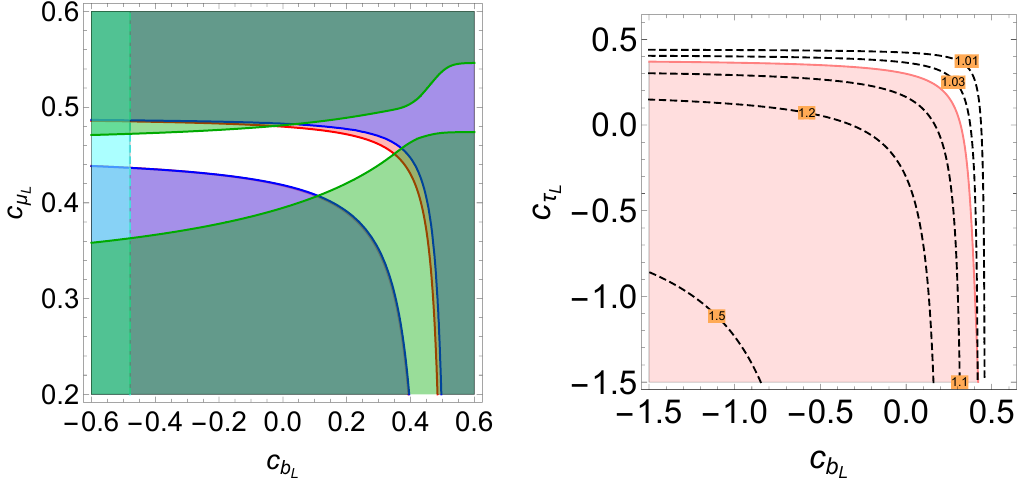
Figure 20 . Left panel: region in the ( c b R 0 (blue line). We also overlap the (cid:13)avor constraints region c b the excluded region corresponding to R (cid:28)=(cid:22) (cid:28) [cf. (cid:12)gure 18 (right panel)]. The white region is allowed for any value of c (cid:28) . Right panel: contour plot in the ( c b L shaded area corresponds to the bound from g Z